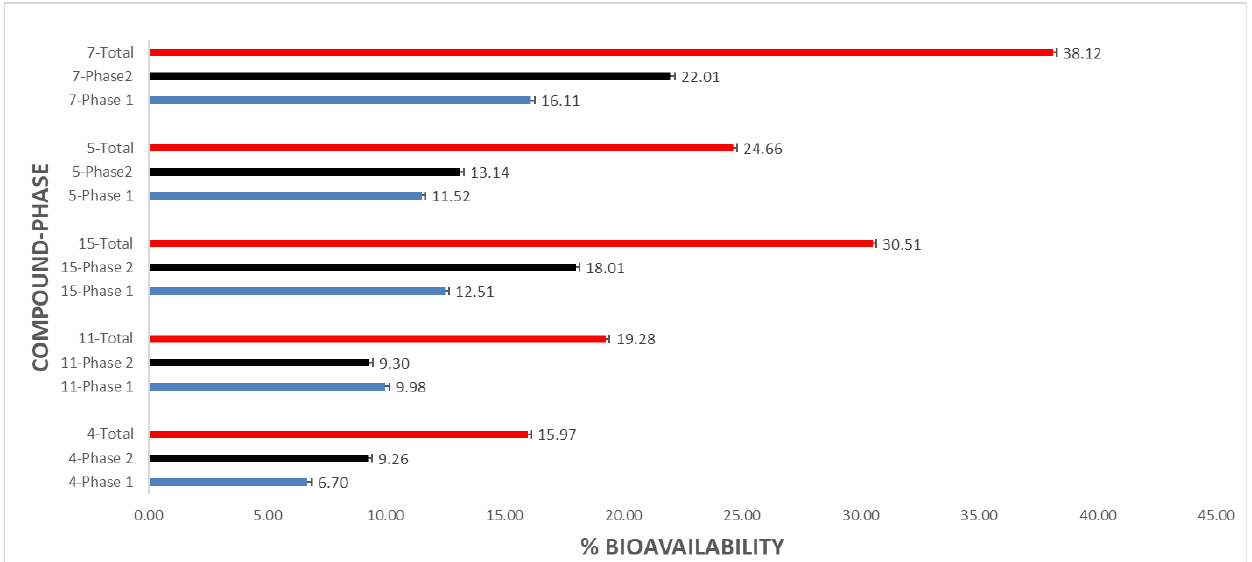
Figure 3. Percentage bioavailability of flavonoid acetamide derivatives after phase 1 & phase 2 digestions, and total in vitro bioavailability. Phase 1-pepsin digestion; phase 2-pancreatin digestion. The error bars show the standard deviation of the population.